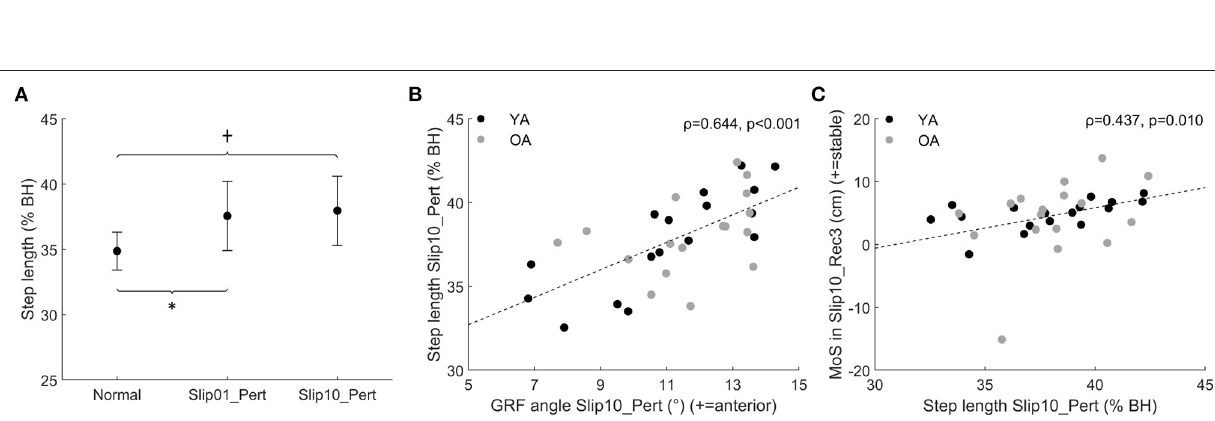
FIGURE 7 | (A) Step length of Slip01_Pert and Slip10_Pert compared with Normal (average ± SD as error bars); *: significant difference between Slip01 and Normal, p < 0.001. †: significant difference between Slip10 and Normal, p < 0.001. See Supplementary Figure 6 for participants’ data points. (B) Correlation between GRF θ during push-off of Slip10_Pert (68–90% of stance) and step length in Slip10_Pert (Spearman’s rho = 0.644, p < 0.001). (C) Correlation between step length in Slip10_Pert and MoS in Slip10_Rec3 (Spearman’s rho = 0.437, p = 0.01). Black circles: young adults; grey circles: older adults. % BH: % body